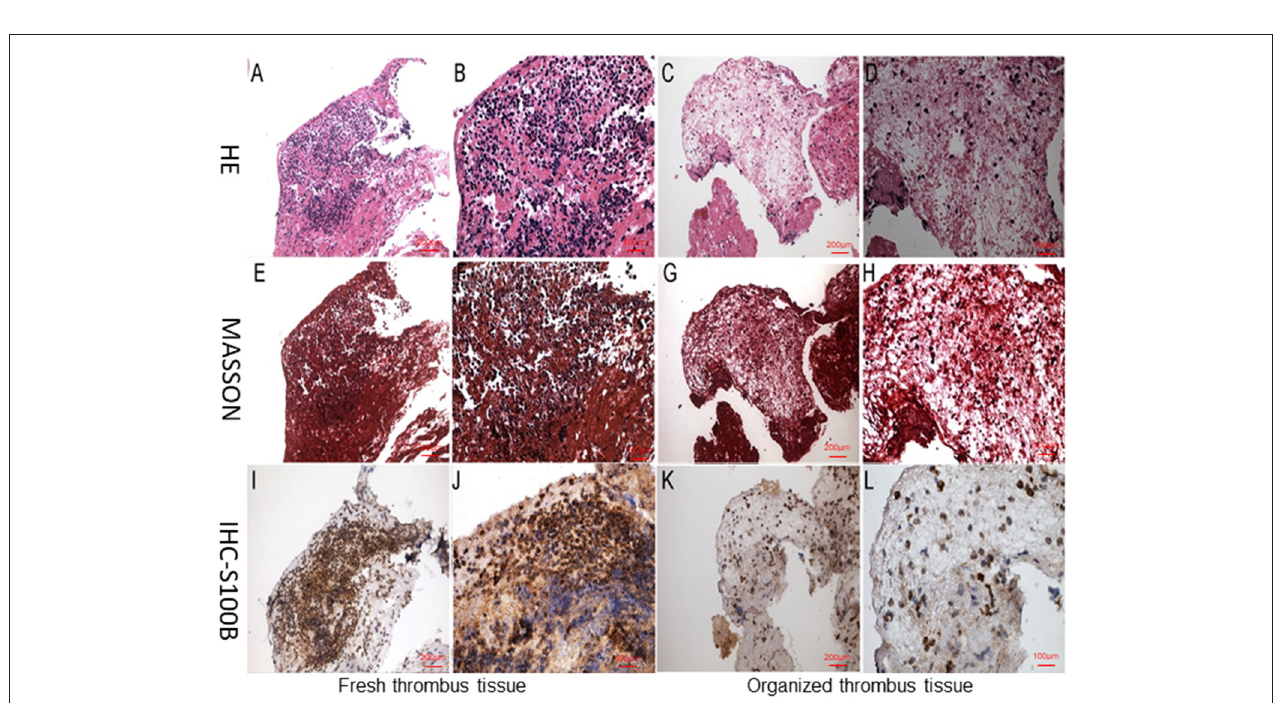
FIGURE 4 | Neutrophil staining during different stages of thrombus organization. (A,B,E,F,I,J) Fresh thrombus tissue with numerous visible neutrophils. (C,D,G,H,K,J) Organized thrombus tissues with largely absent. (A–D) H&E staining of thrombus tissues, (E–H) Masson staining of thrombus tissues, (I–L) Immunohistological staining of thrombus tissues. All samples were histologically graded as either fresh thrombi containing numerous neutrophils, or organized thrombi with a few neutrophils. Image magnification × 10 and × 20.Immunoreactivity was detected using DAB staining (brown